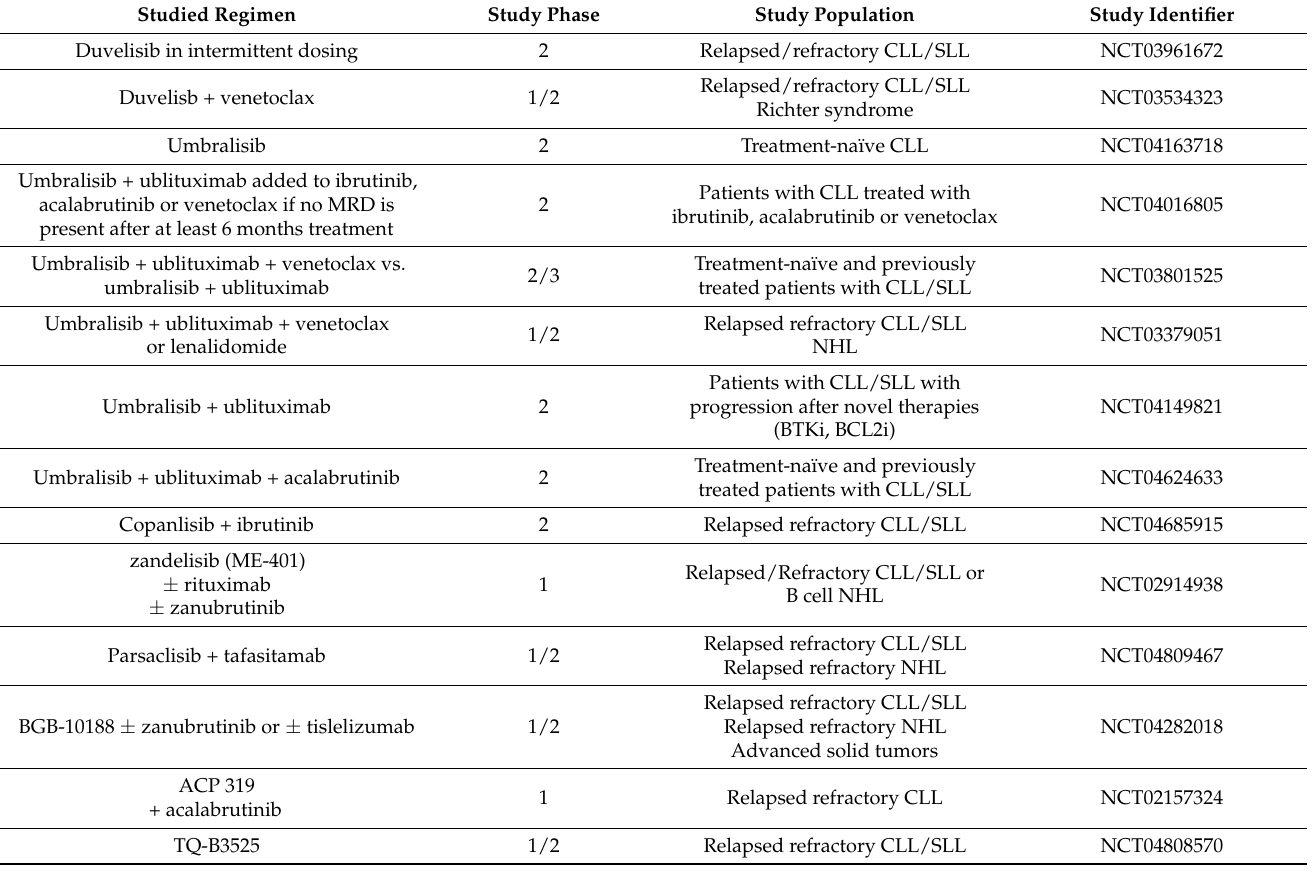
Table 5. Ongoing studies with PI3K inhibitors in monotherapy and novel